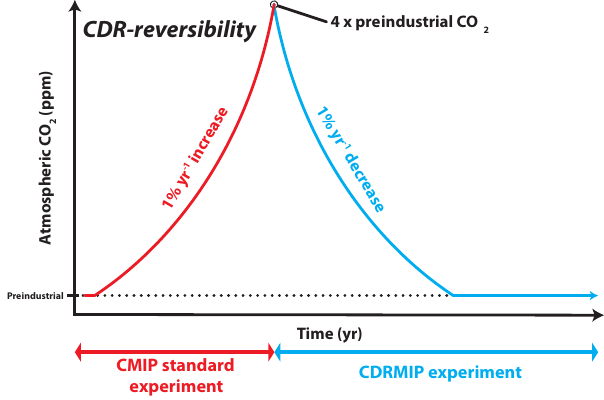
Figure 1. Schematic of the CDRMIP climate and carbon cycle re- versibility experimental protocol ( CDR-reversibility ). From a prein- dustrial run at steady state atmospheric CO 2 is prescribed to in- crease and then decrease over a ∼ 280-year period, after which it is held constant for as long as computationally